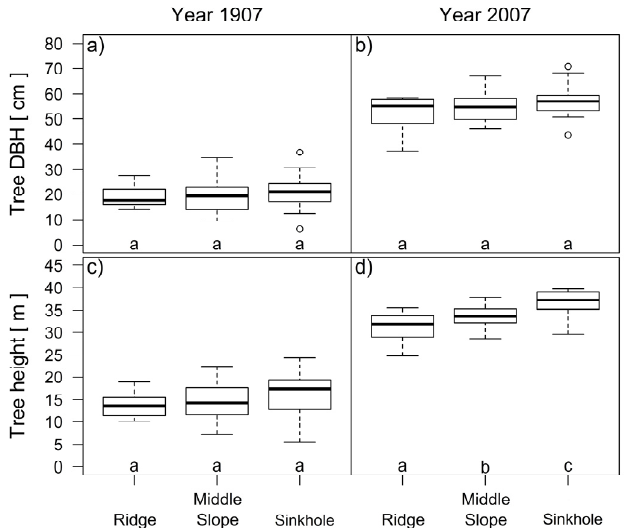
Figure 9. Comparison of the tree diameters ( a , b ) and tree heights ( c , d ) of silver fir trees on different landform categories 100 years ago and at the time of this study. Different letters in figure ( d ) indicate significant differences (Tukey’s HSD test, p < 0.05) in tree heights between all three groups of trees on ridge, middle slope and sinkhole categories in 2007.